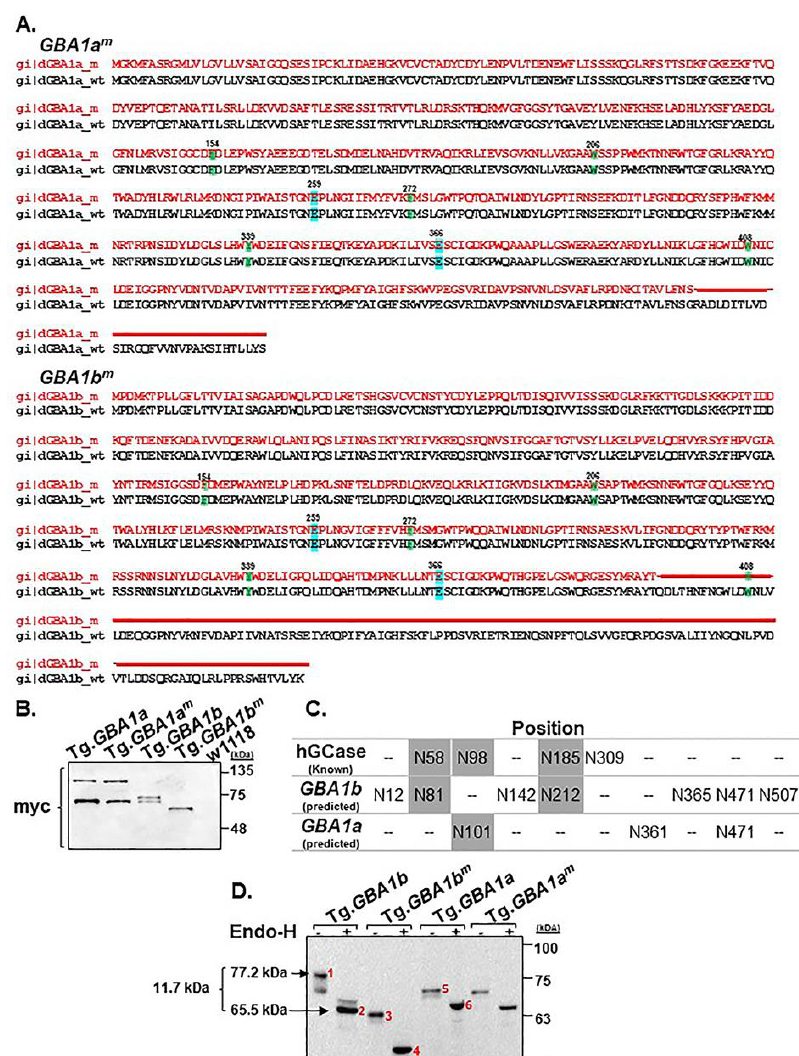
Figure 2. Protein products of the fly mutant alleles. ( A ) Mutant protein sequences (red) of GBA1a ( GBA1a m ) and GBA1b ( GBA1b m ) compared to the wt protein sequence (black). Red lines represent the deletion in each mutant protein (33 C-terminal amino acids in GBA1a m and 133 C-terminal amino acids in GBA1b m including W408 that stabilizes the substrate). Blue color highlights amino acids comprising the active site. Green color highlights amino acids associated with substrate recognition [33]. ( B ) Protein expression of normal and mutant GBA1a and GBA1b alleles, coupled to a myc-tag in transgenic (Tg.) flies, expressed under the daughterless (Da)-GAL4 driver. ( C ) Known glycosylation sites in human GCase and predicted ones in Drosophila GBA1a and GBA1b -encoded GCases. Common sites in fly and human GCases are highlighted with gray. ( D ) Protein lysates, prepared from transgenic (Tg.) flies expressing wt or mutant myc-tagged GBA1a or GBA1b cDNAs, under the Da-GAL4 driver, were incubated with or without endo-H. The lysates were electrophoresed through SDS–PAGE and the corresponding blot was interacted with anti-myc antibody. Peptides 1 and 2 represent GBA1b -encoded GCase before and after endo-H treatment, respectively. Peptides 3 and 4 represent mutant GBA1b m -encoded GCase before and after endo-H treatment, respectively. Peptides 5 (71.8 kDa) and 6 (67.4 kDa) represent GBA1a -encoded GCase before and after endo-H treatment, respectively.